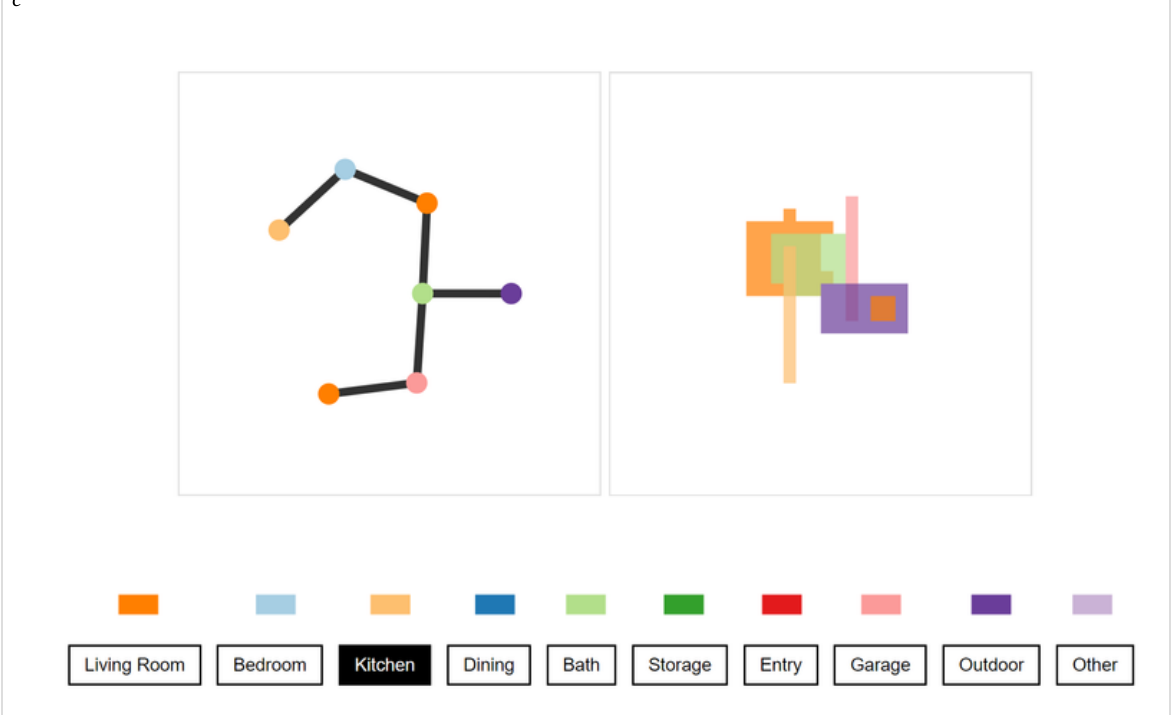
Figure 2. Representation of a typical floor plan as a graph ( 2a and 2b) and final result, where the user of the web app inputs the rooms (kitchen, living room, etc.) as nodes of a graph that are then combined into a floor plan (2c) . Li, Ao, Tian, Runjia, Wang, Xiaoshi and Yueheng Lu. PlanGCN Team.